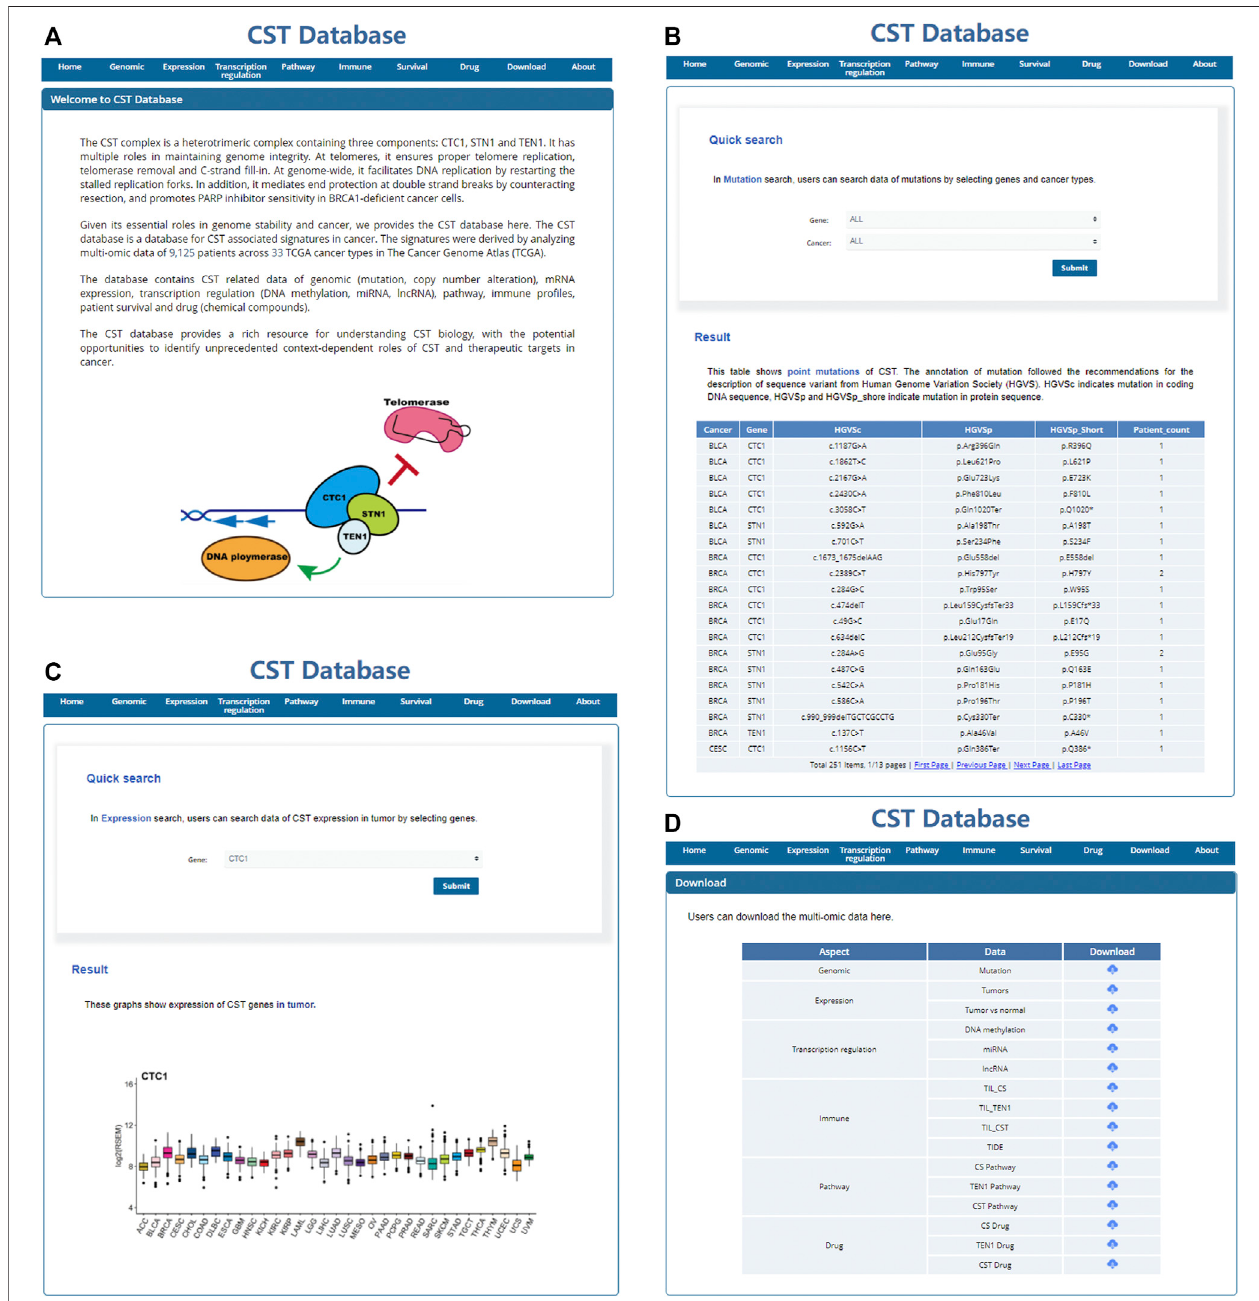
FIGURE 8 | User-friendly, open access CST database. Screenshot of the home page (A) , search page (B,C) , and download page (D) of the CST database.